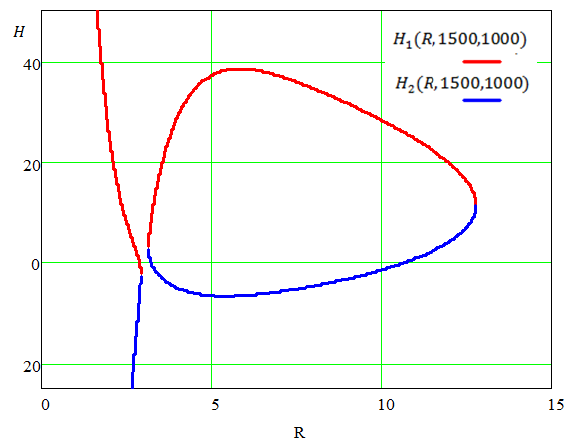
Figure 16. Initial set of the solutions of Equation (18).